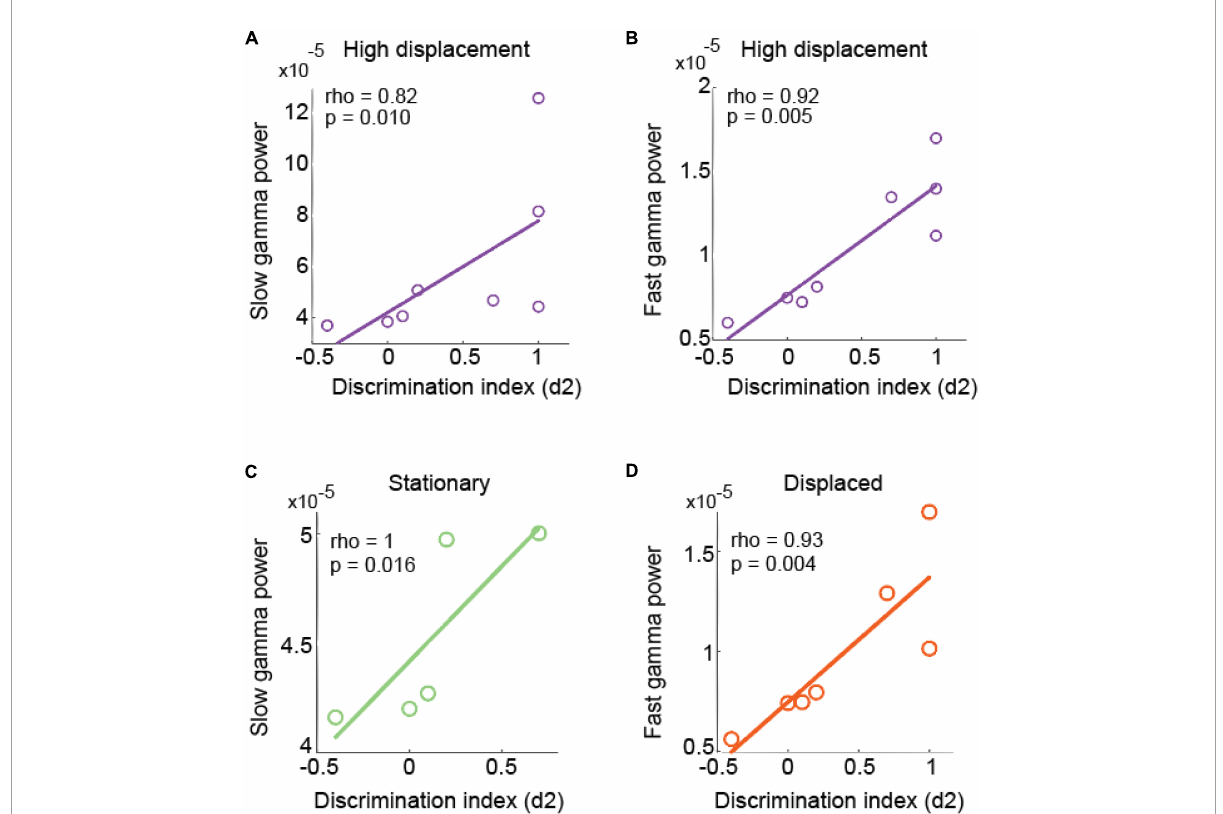
FIGURE6 Relationship between the discrimination index and the power of slow and fast gamma bands in CA1 during exploration of displaced and stationary objects in high displacements (HD) tests. Relationship between the discrimination index and the power of slow gamma (A) and fast gamma (B) bands exhibited in the right CA1 during object exploration in HD tests. Circles represent individual animals, and the straight line depicts the linear relationship between variables. (C) Relationship between the power at slow gamma band exhibited during exploration of stationary (green) objects and the discrimination index in HD tests. (D) Relationship between the power at fast gamma band exhibited during exploration of displaced (orange) objects and the discrimination index in HD tests. Panels (A–D) represent 8, 5 and 7 animals,